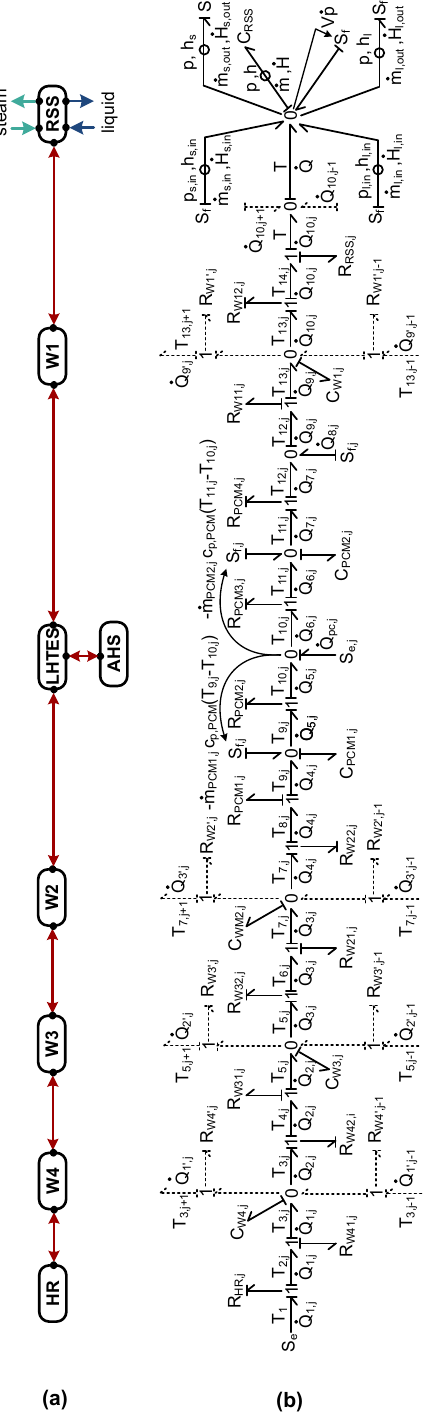
Figure 2. Hybrid storage model. ( a ) Structure of the model. ( b ) Bond graph. The wall sub-model is used four times inside the hybrid storage model. The wall W3 in Figure 2 is used to model the insulation of the storage vessel. For the most inner wall W1 (Figure 3), the equations of the wall sub-model are presented. With the mean diameter, the thermal capacity of the wall is considered. The mean diameter is calculated in relation to the volume. The thermal capacity C W 1, j and the resistances for the heat flow in the radial direction R W 11, j and R W 12, j are calculated with Equations